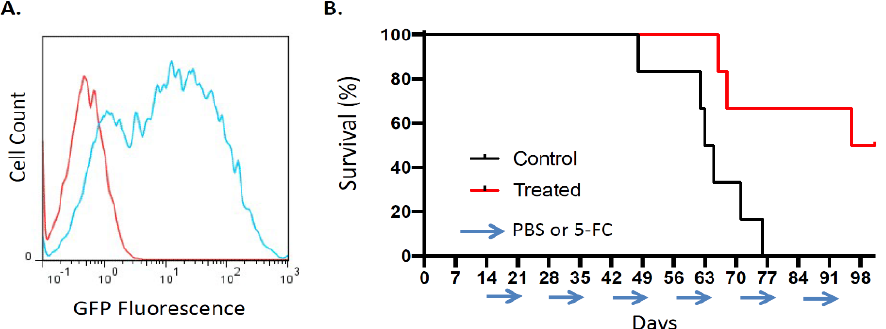
Figure 6. Tumor transduction and therapeutic efficacy of RRV in orthotopic pleural dissemination model of human lung cancer after vector injection directly into the thoracic cavity. Disseminated pleural tumors were established by intrathoracic injection of A549 cells into athymic nude mice on day 0 ( n = 6). ( A ) RRV-GFP vector (2 × 10 6 TU/500 μL) was injected into the thoracic cavity on day 2, and tumors were excised on day 14 and disaggregated for flow cytometry. Histograms show representative flow cytometric results quantitating GFP expression levels in uninfected negative control tumor (red curve) and in RRV-GFP-infected tumor (blue curve, 71.1% GFP-positive). ( B ) Kaplan–Meier survival analysis in lung cancer pleural dissemination model established as above, after intrathoracic injection of RRV Toca 511 via the same route, followed by 5-FC prodrug (‘Treated’) or PBS vehicle (‘Control’) administered in 7-day cycles every other week (arrows).